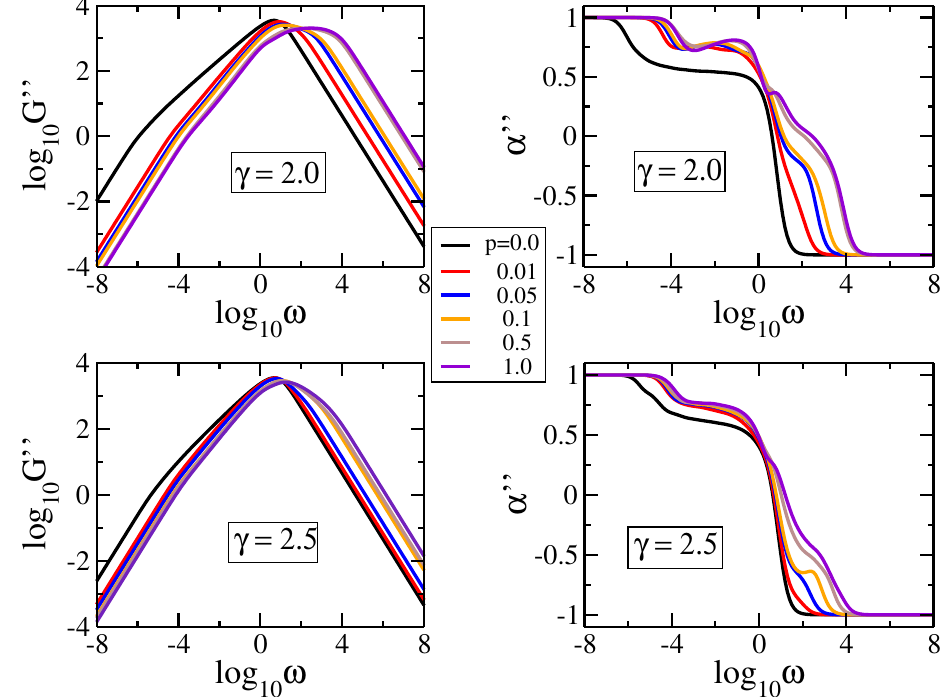
Figure 5. Loss modulus and its derivative for pDSFNs with N = 10,000 and various values of p , having γ = 2.0 and 2.5. The frequency ω has units of σ = K / ζ